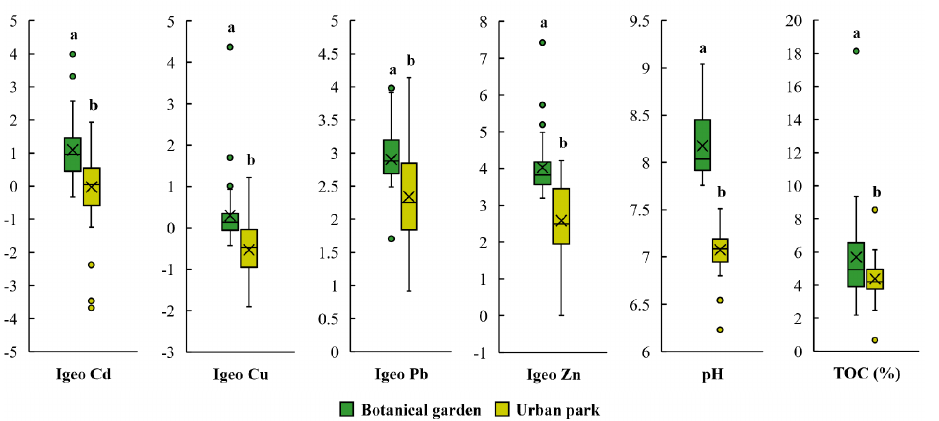
Figure 5. Comparison of PTE contamination (using Geoaccumulation Index, I geo ), pH and TOC of botanical garden and urban park topsoil; different letters indicate significant differences at p = 0.05, Tukey HSD test.